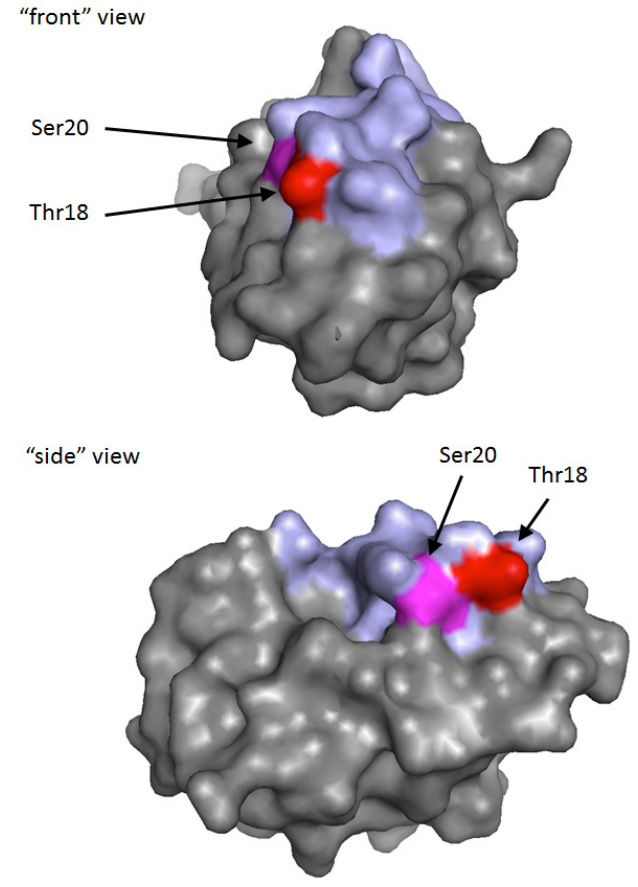
Figure 4. Location of key phosphorylation sites in the N-terminus of p53 within the context of MDM2 association. The X-ray diffraction-based structure of an N-terminal peptide of human p53 (pale blue) in complex with the N-terminal domain of MDM2 (grey) is shown. The figure depicts two views: termed "front" and, following rotation of approximately 90° around the vertical plane, "side". The positions of the threonine 18 (red) and serine 20 (magenta) phosphorylation sites are shown. The data are taken from coordinates placed in the NCBI database (accession number: